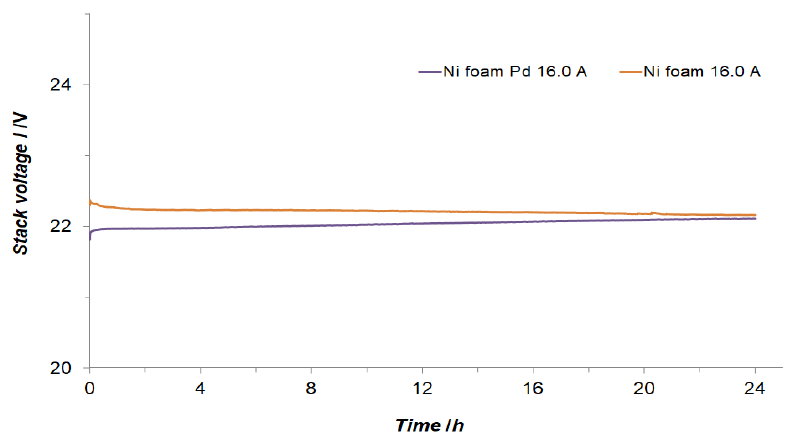
Figure 9. Electrolyser stack’s voltage in function of electrolysis time. The process was carried-out at 45 °C in 8 M KOH solution for current intensity of 16.0 A (anode: Ni foam; cathode: Ni foam or Pd-modified Ni foam) and solution recirculation rate of 50 cm 3 min − 1 .